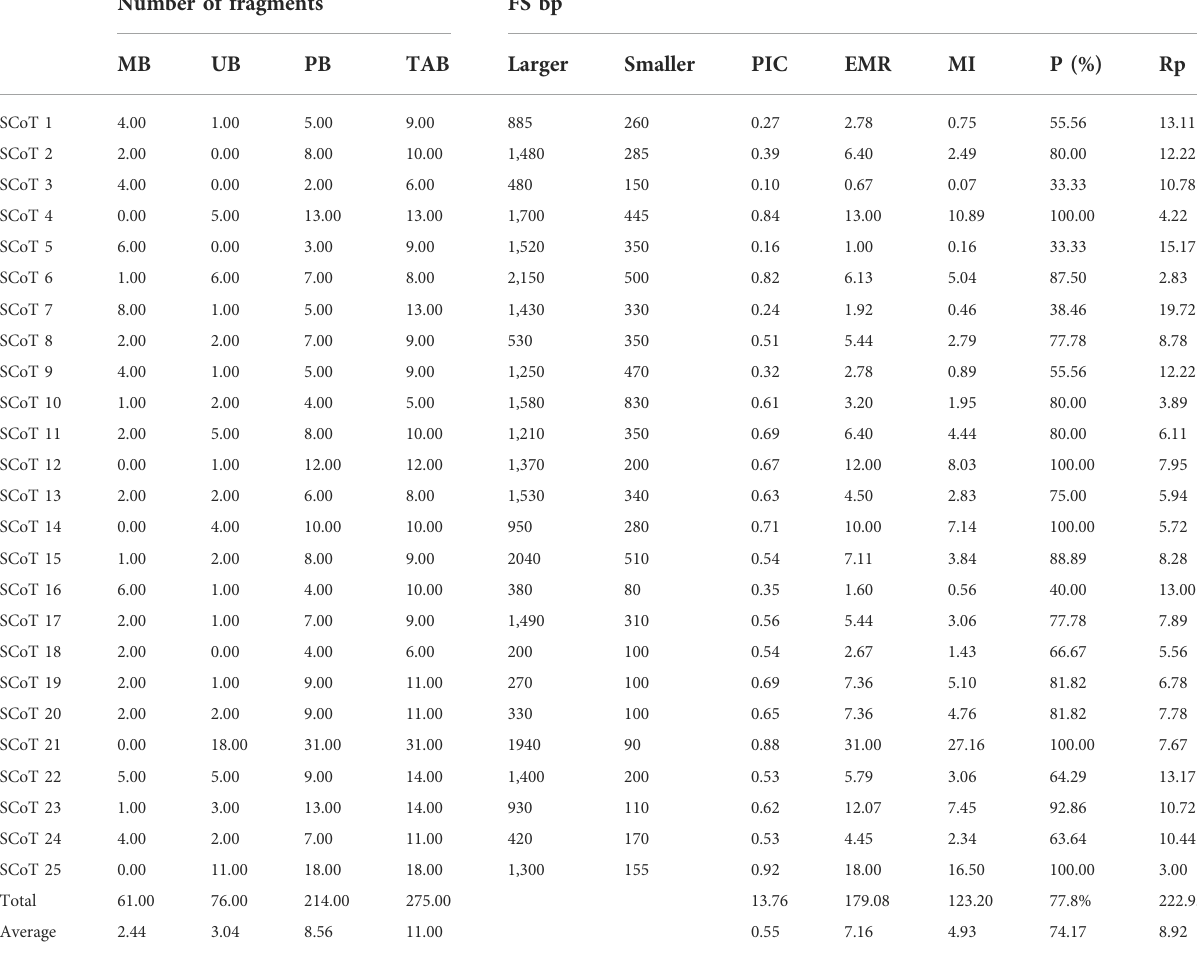
TABLE 4 Types and number of generated DNA bands, polymorphism percentage, and informativeness comparison obtained via SCoT primers. Number of fragments FS bp MB UB PB TAB Larger Smaller PIC EMR